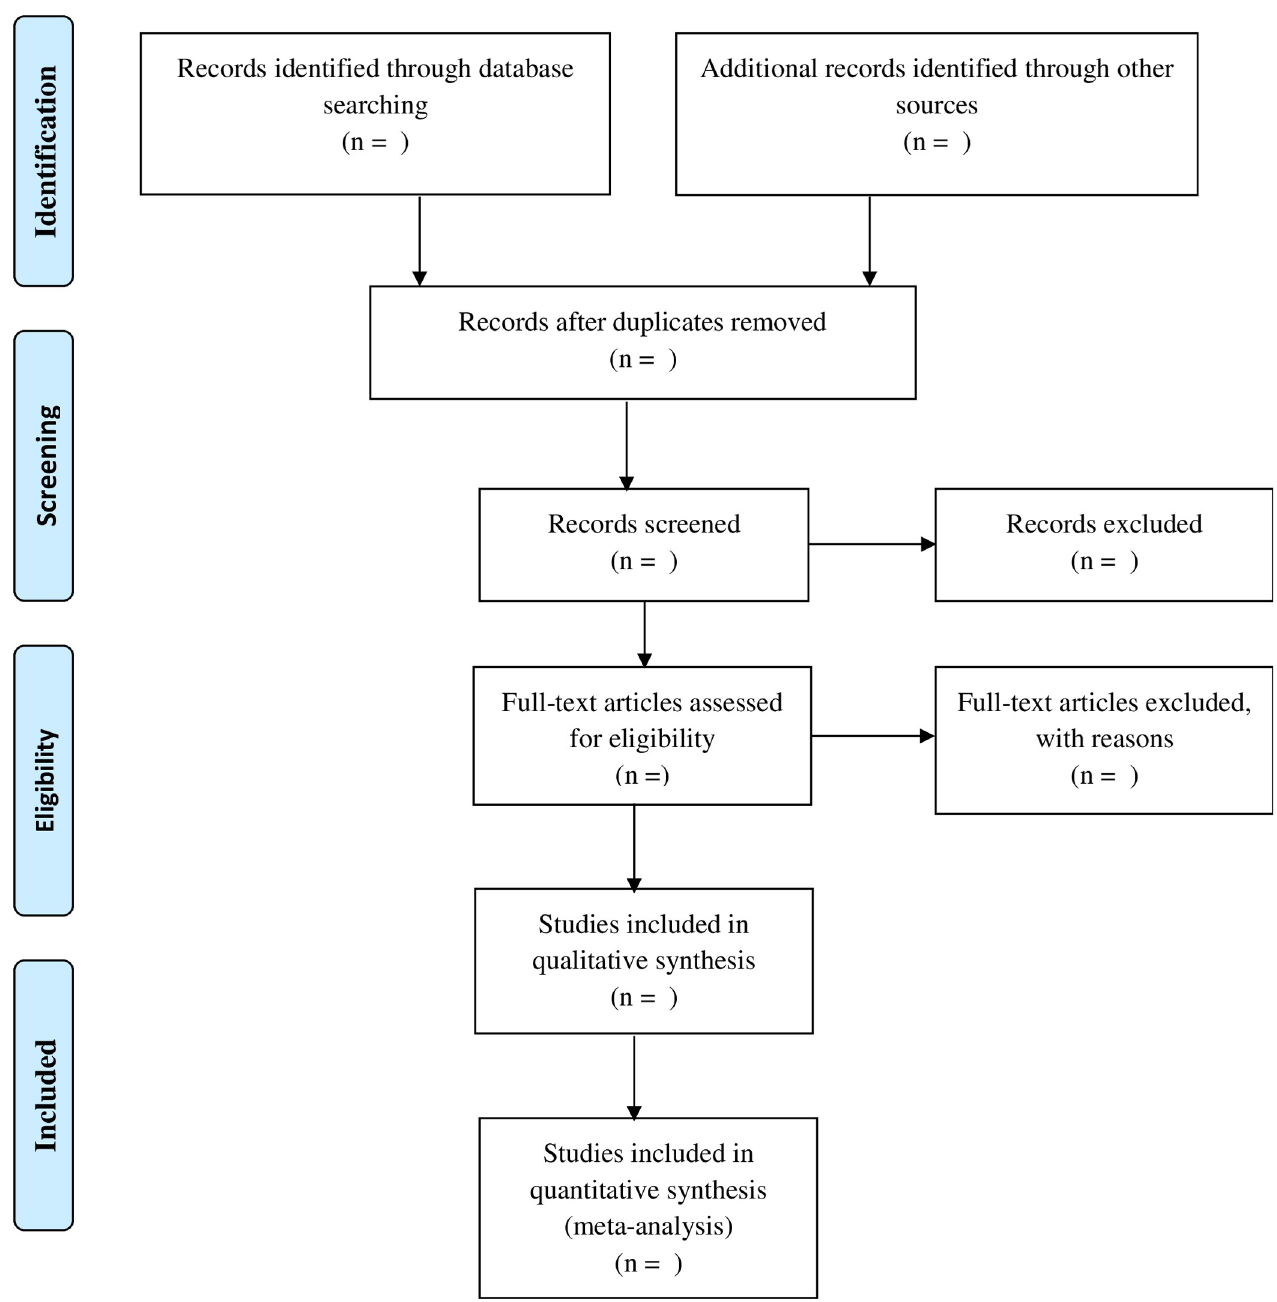
Fig 1. PRISMA flowchart for the selection of eligible